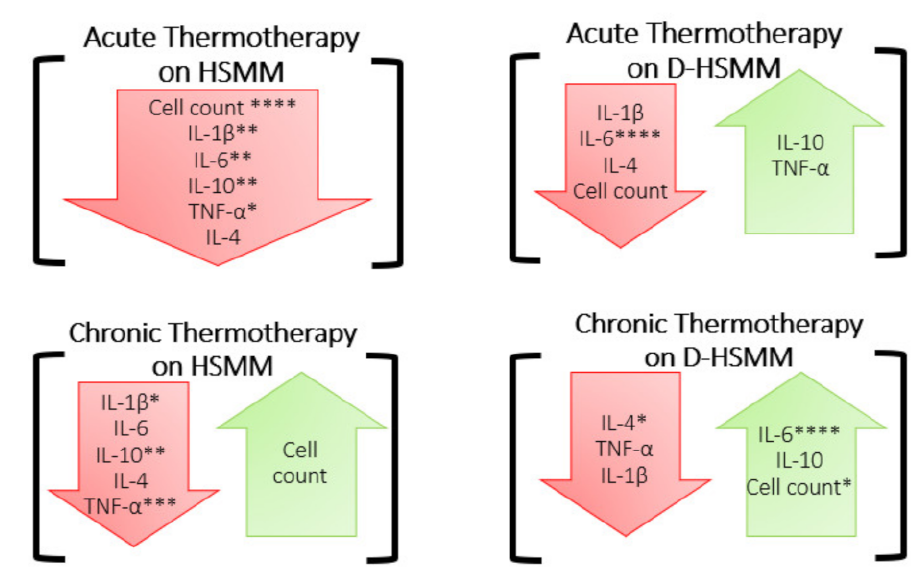
Figure 5. Summary of the findings of this study. The red arrows indicate a decrease, compared to the control, while the green arrows indicate an increase, compared to the control, following each heat treatment. The significance was determined when p ≤ 0.05 (*), p ≤ 0.01 (**), p ≤ 0.001 (***), or p ≤ 0.0001